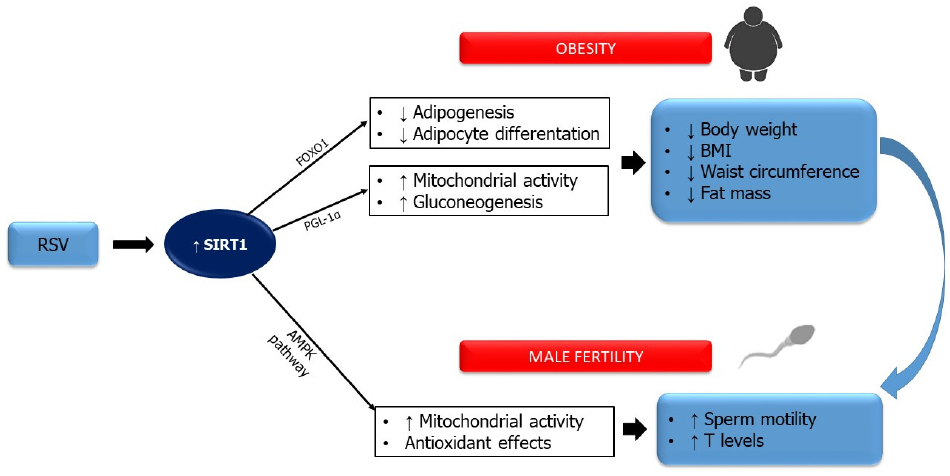
Figure 2. Effects of sirtuin-1 (SIRT1) activation by resveratrol (RSV) on obesity and male fertility. Strategies that attempt to improve SIRT activity could be used to counter infertility caused by excess weight in infertile male patients. Several molecules have been studied as activators of SIRTs, particularly RSV. Indeed, its administration seems to have a beneficial role both in obesity by reducing body weight, body mass index, waist circumference, and fat mass, and on fertility by increasing testosterone levels. Abbreviations: AMPK: monophosphate-activated protein kinase; FoxO1: Fork- head box protein O1; PGC-1 α : peroxisome proliferator-activated receptor γ coactivator-1 α ; SIRT-1: deacetylating enzyme